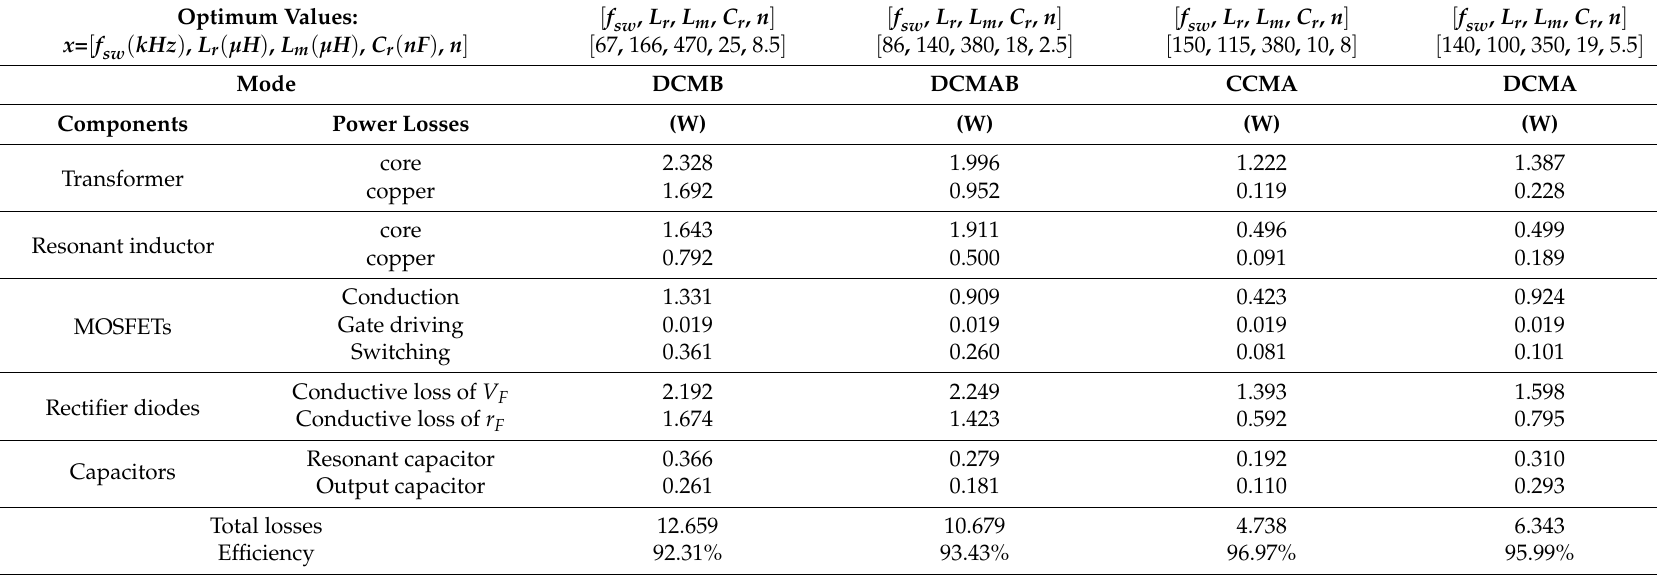
Table 6. Losses Profile of LLC resonant converter by LSQ optimization